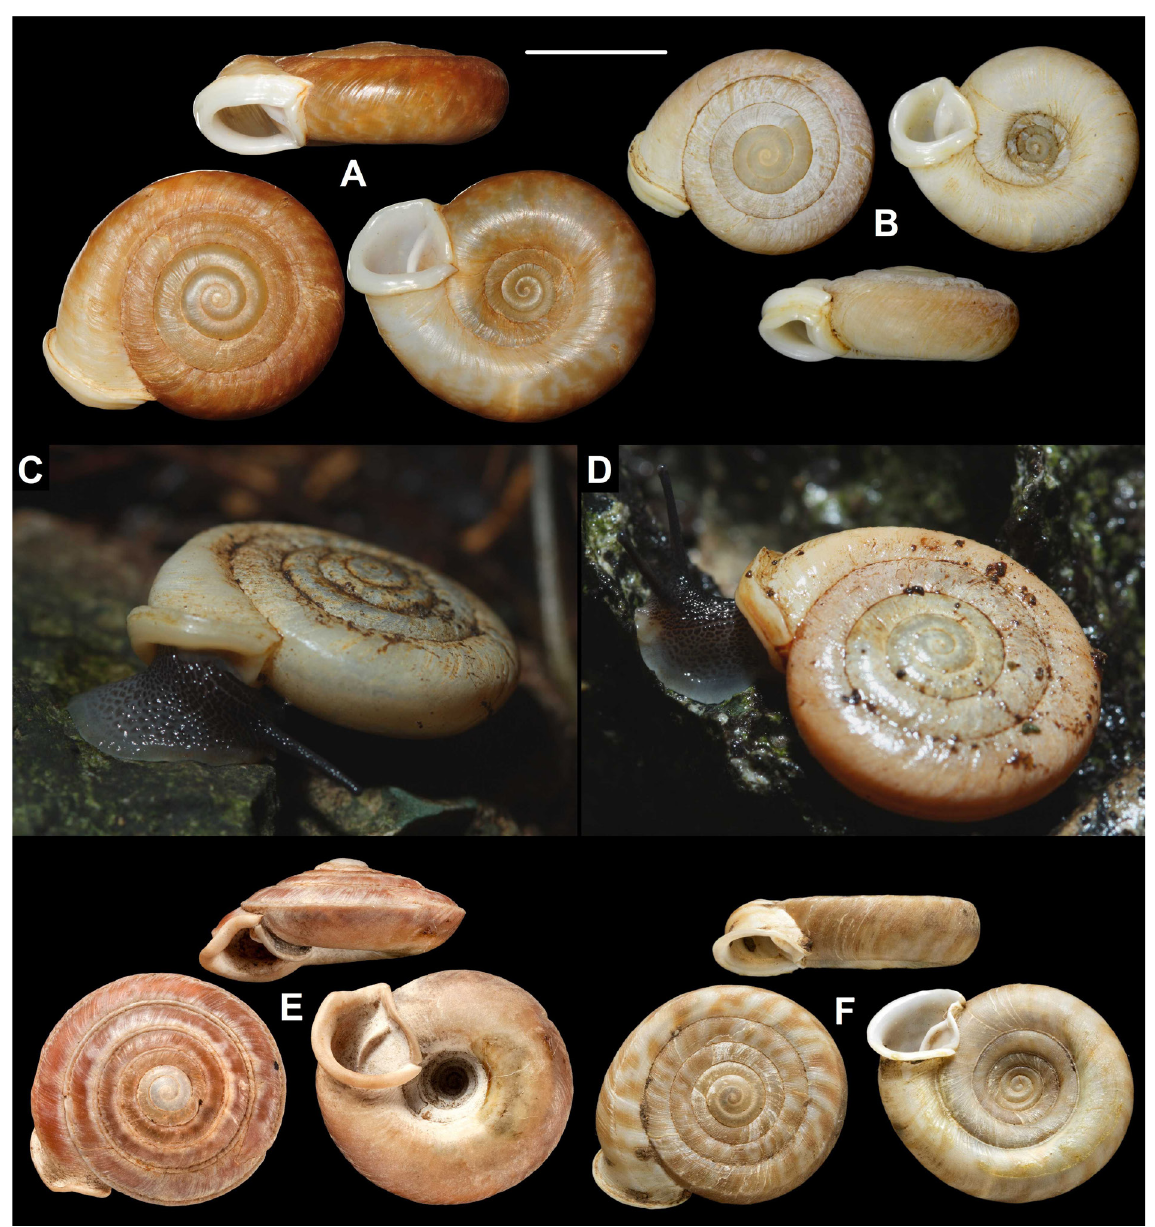
Fig. 41. Shells and living specimens of species of Plectopylis Benson, 1860. A . P. crassilabris sp. nov., holotype (UF 279203). B . P. crassilabris sp. nov. (UF 346364). C–D . Living specimens photographed in the Khao Wong National Park, Aug.–Sep. 2010. E . P. cyclaspis (Benson,